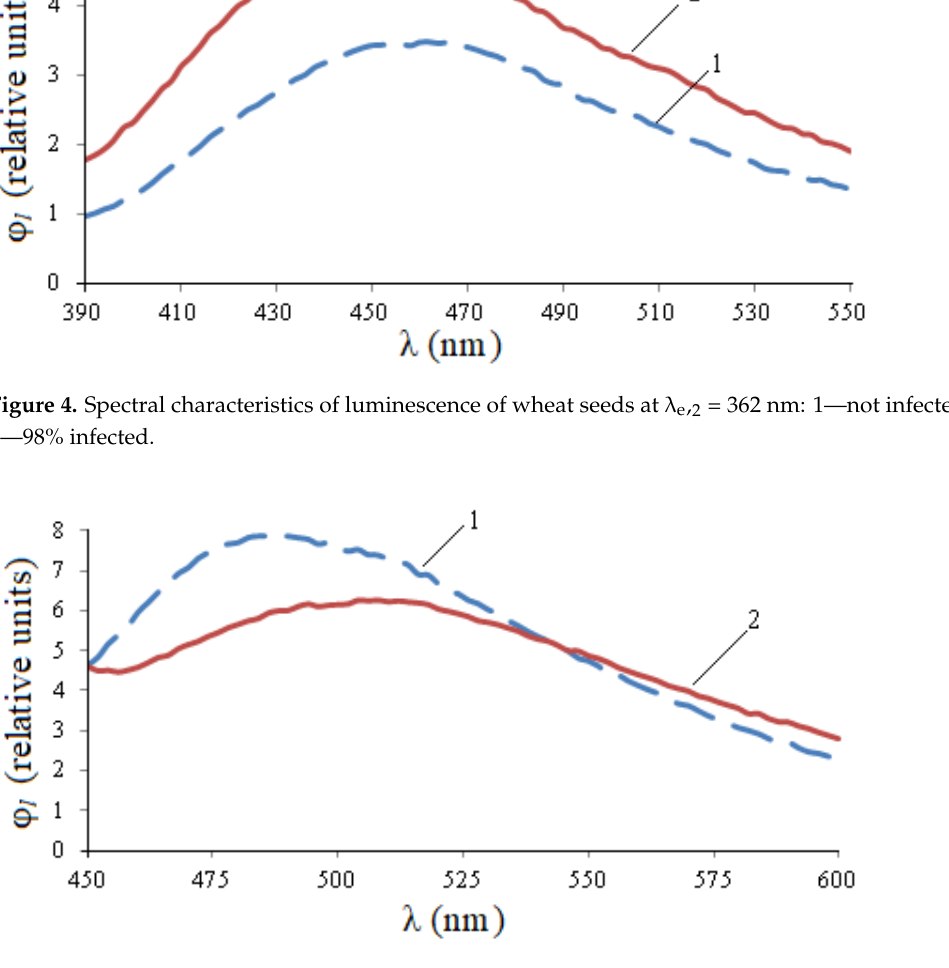
Figure 5. Spectral characteristics of luminescence of wheat seeds at λ e , 3 = 424 nm: 1—not infected, 2—98% infected.